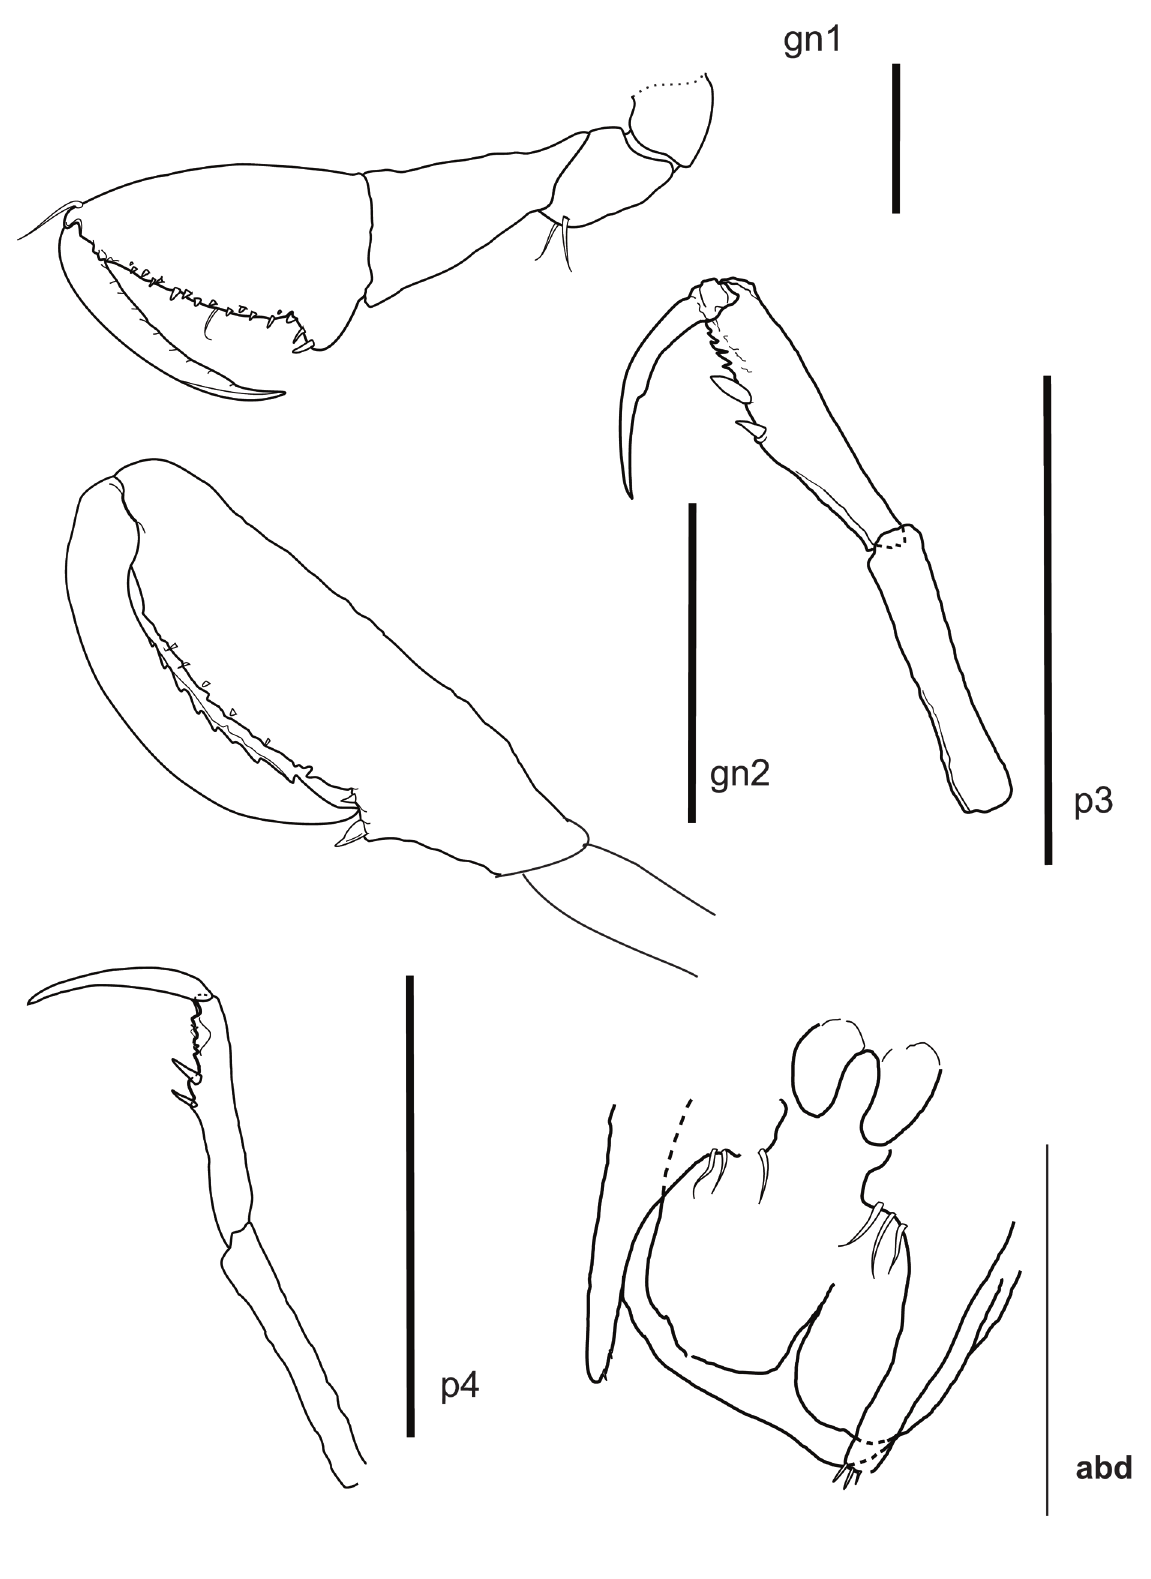
Fig. 2. Hemiproto wigleyi (McCain, 1968). Male, 8.5 mm, Campos Basin, RJ (MNRJ 25515). Scale bars: gn1, abd = 0.1mm; gn2, p3, p4 = 0.1